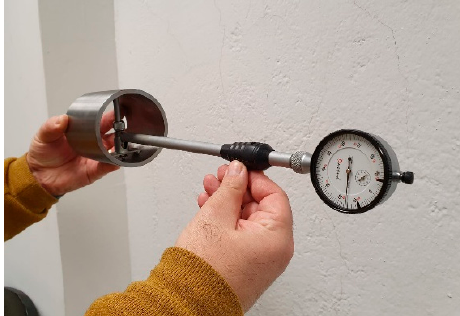
Figure 4. Alexometer used to measure the internal diameter of the cylinders.